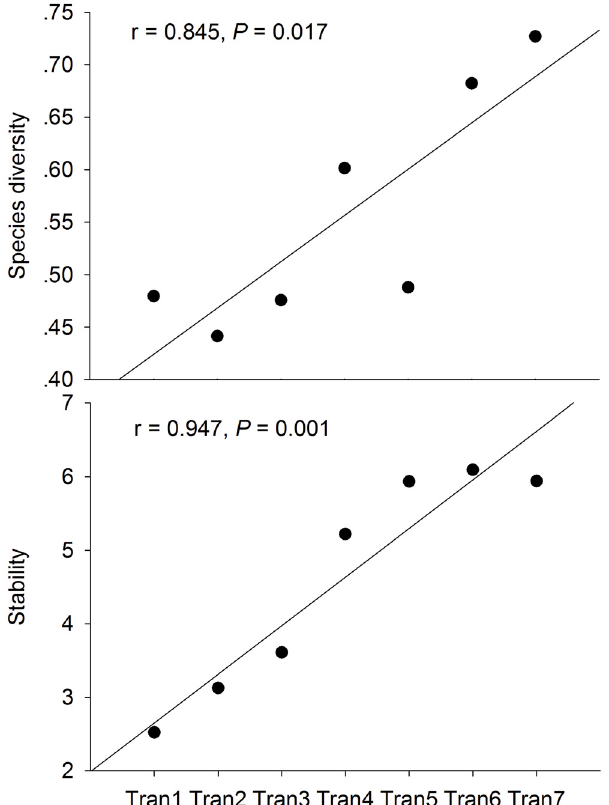
Fig 1. Both species diversity and community stability increase with increasing resources